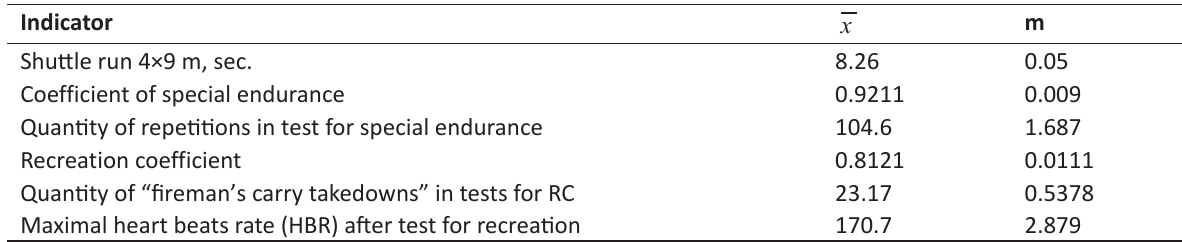
Table 1. Indicators of qualified wrestlers’ pedagogic testing in special training stage of preparatory period ( х ±m; n=18) Indicator Shuttle run 4×9 m, sec.